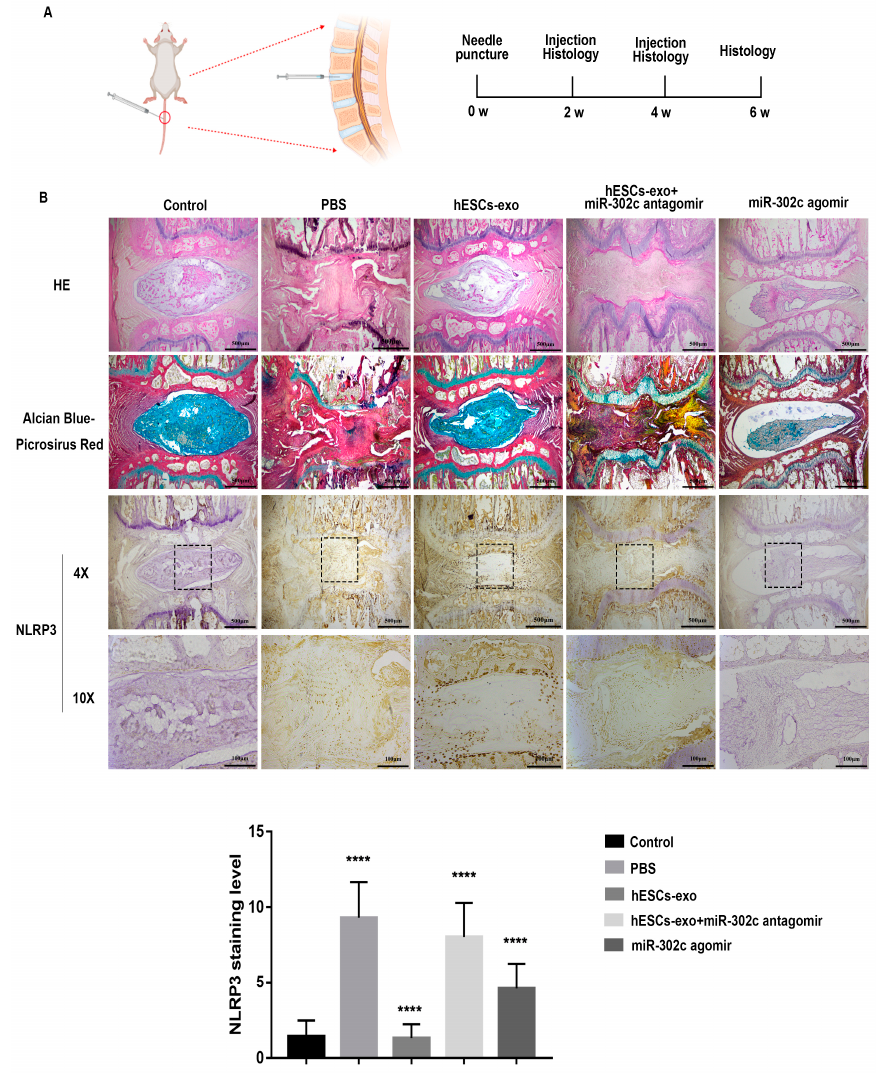
Figure 4. hESCs-exo-derived miR302c could retard IVDD in a rat model. ( A ). Image of the construction of a disc degeneration model created with BioRender.com. ( B ). Images of HE, Alcian blue/Picrosirius red staining, IHC staining of NLRP3, and quali fi cation analysis in the di ff erent groups are shown. The data are shown as the means ± SD, n = 3. The PBS group compared to the control group, the hESCs-exo group compared to the PBS group, the hESCs-exo + miR-302c antago- mir group compared to the hESCs-exo group, the miR-302c agomir group compared to the PBS group. **** p < 0.0001.